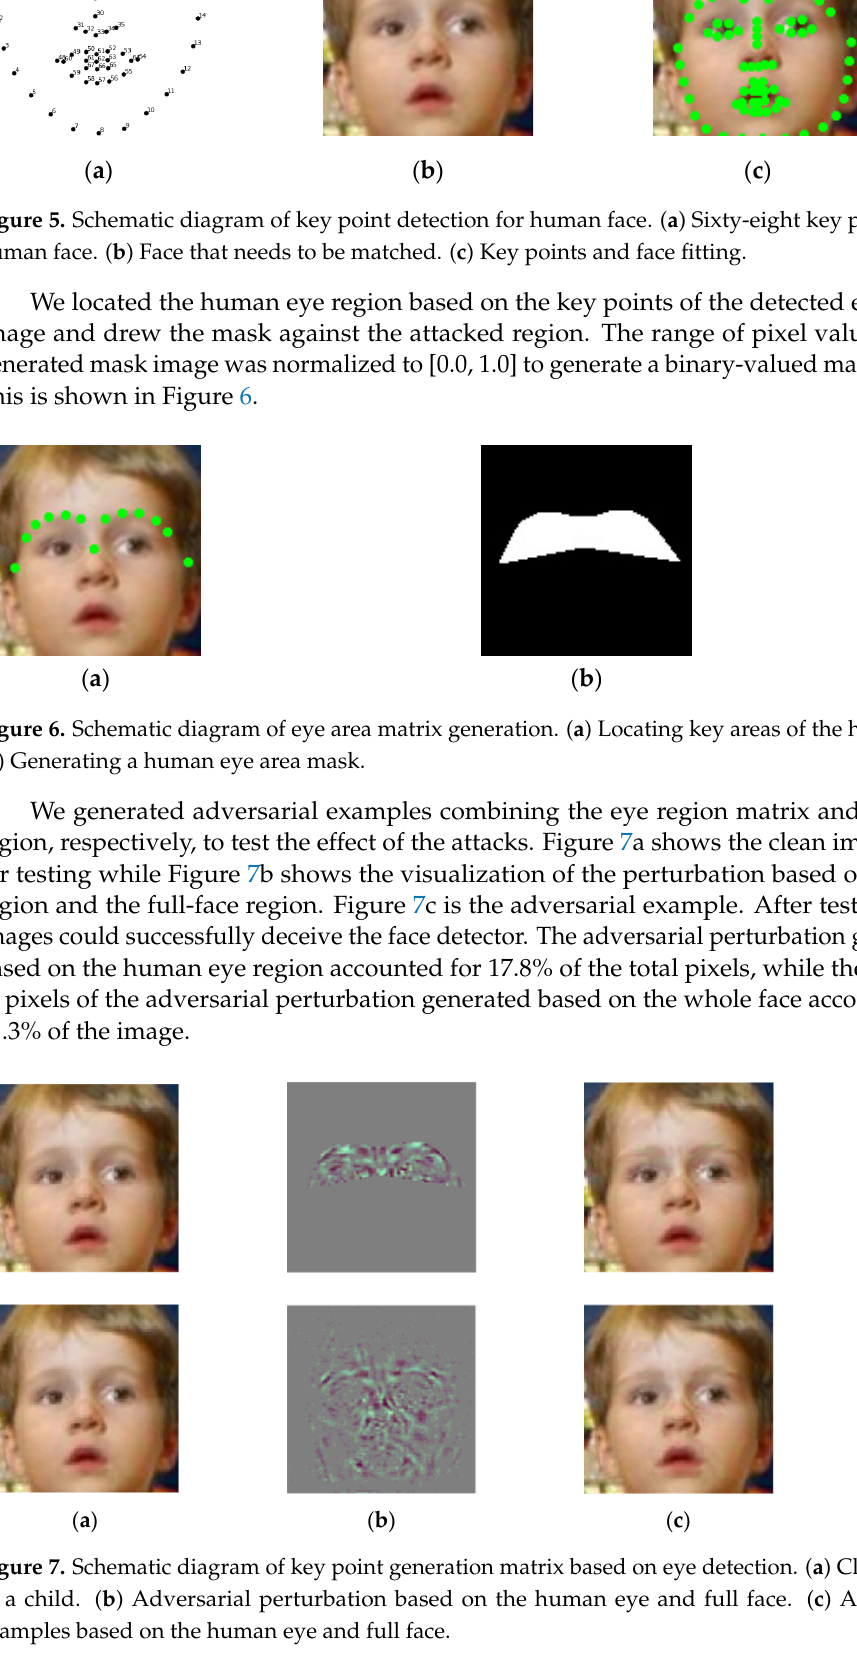
( f ) Figure 4. The process of face recognition and face alignment. ( a ) Clean image of a child. ( b ) Image pyramid. ( c ) Bounding box regression. ( d ) Merging the candidate objects. ( e ) Face location. ( f ) Key point location. Pixels are randomly sampled within the range of key points as the corresponding feature pixel [29]. The feature pixels select the closest initial key point as the anchor and calculate the deviation. The coordinate system of the current pixel after rotation, transfor- mation, and scaling should be close to the initial key point. It acts on the deviation and adds its own position information to obtain the feature pixel of the current key point. Then, we constructed the residual tree and calculated the deviation of the current key